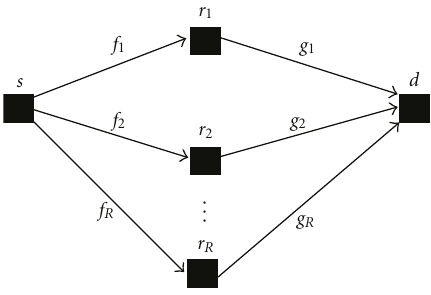
Figure 1: Wireless relay network consisting of a source s , a destination d , and R